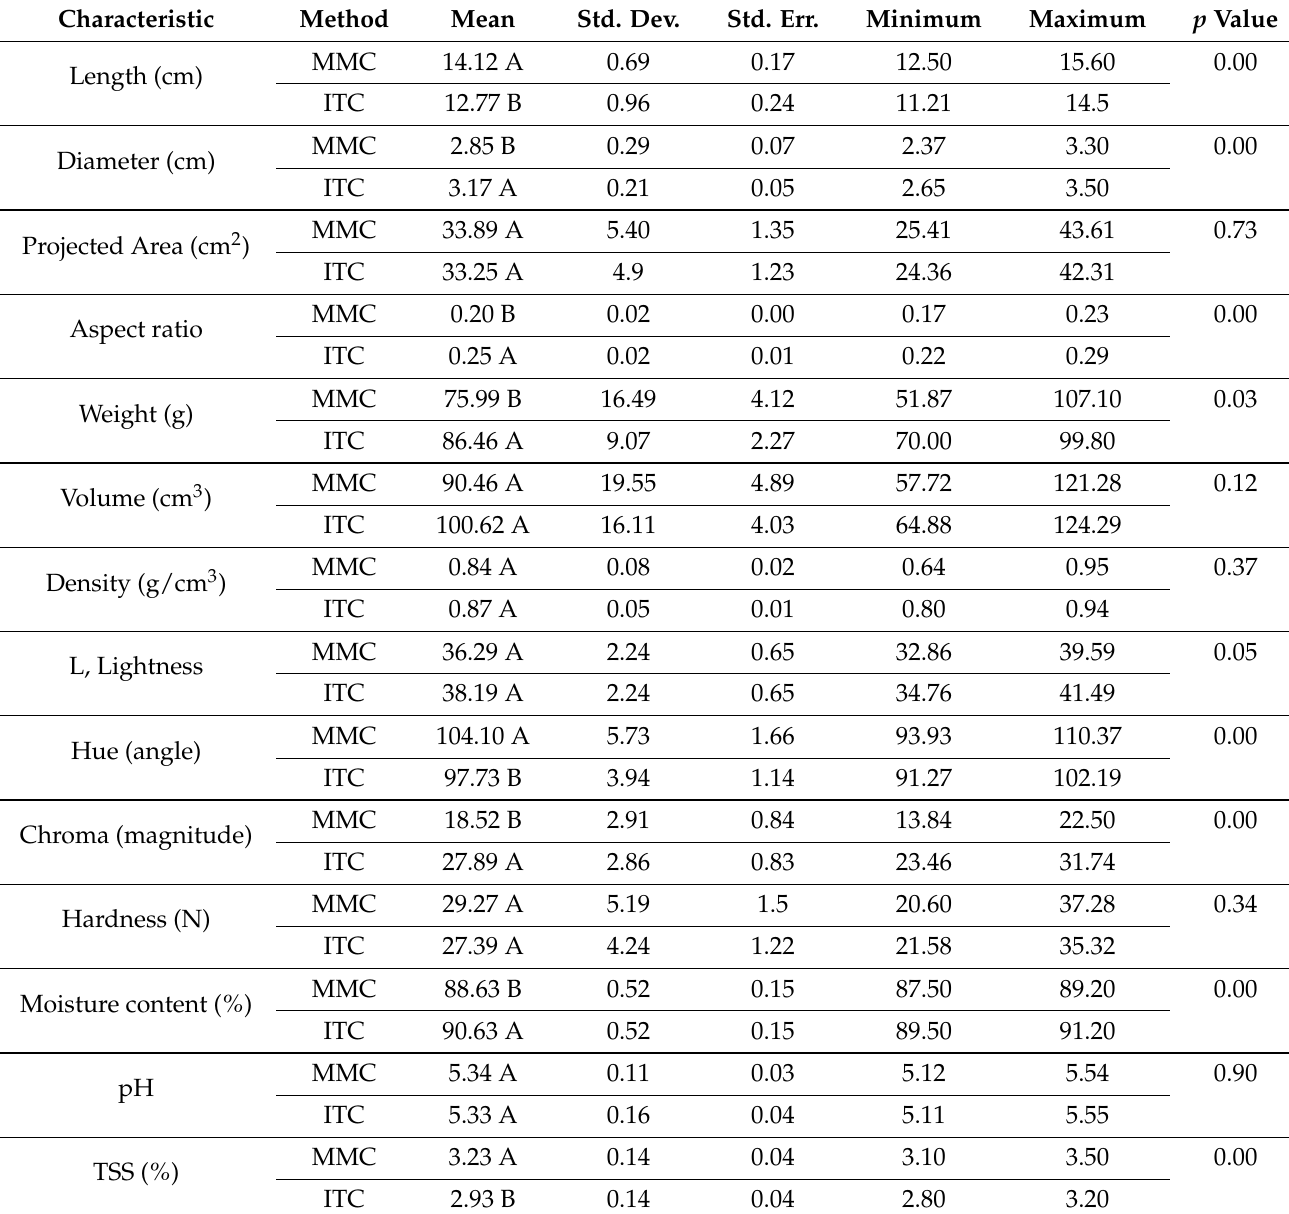
Table 1. Response of cucumber fruit physicochemical characteristics under different irrigation water control system of medium moisture control (MMC) and irrigation timing